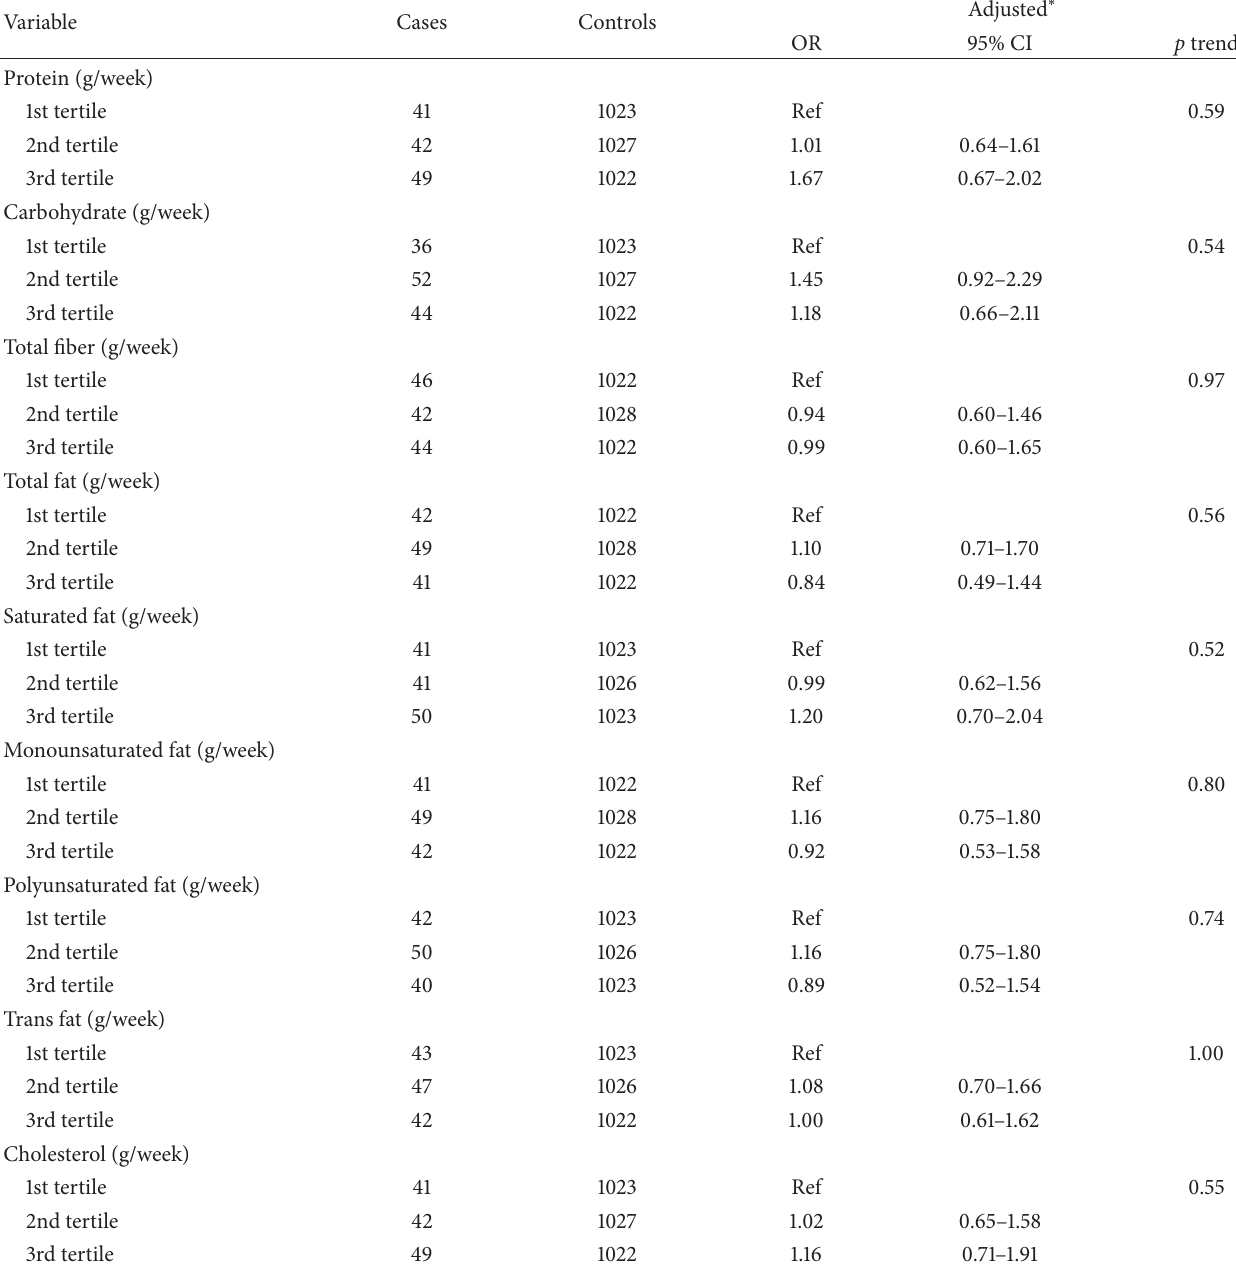
Table 4: Odds ratios of salivary gland cancer associated with some